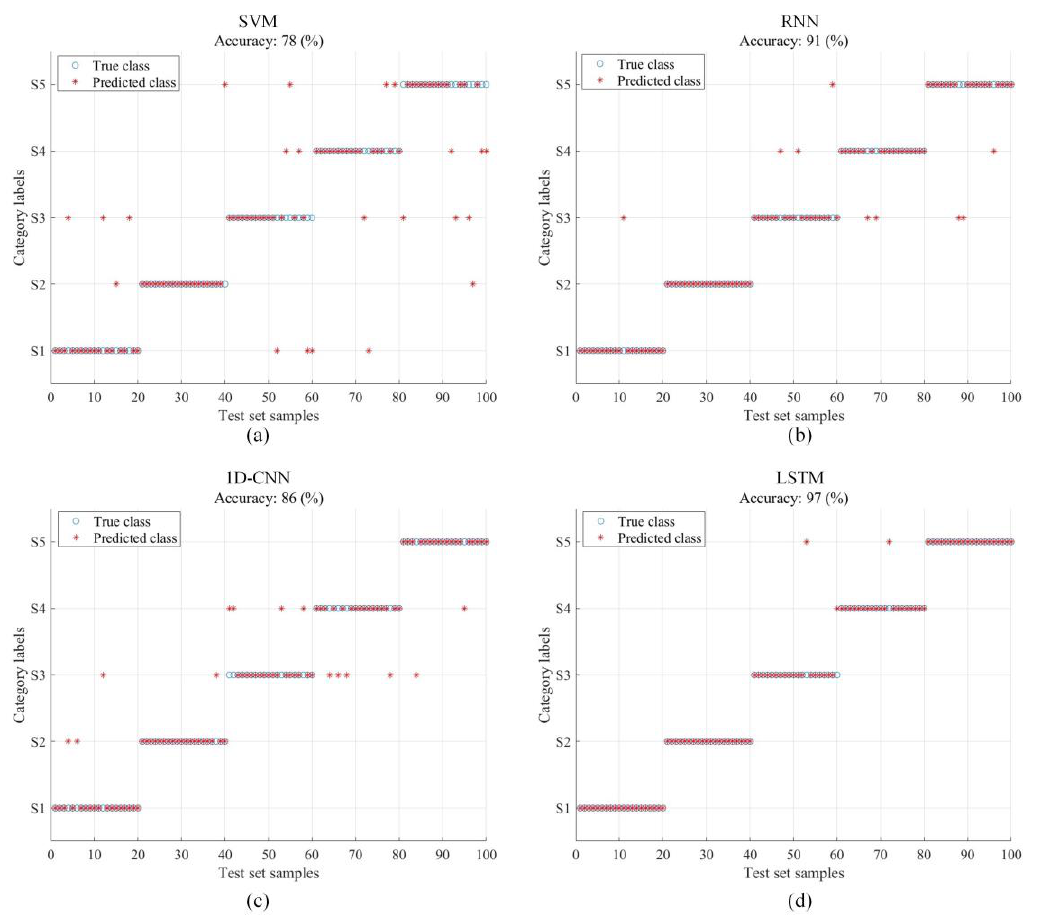
Figure 14. Diagnostic results of VMMFCC in different classifiers ( a ) SVM; ( b ) RNN; ( c ) 1D-CNN; ( d ) EEMMFCC.